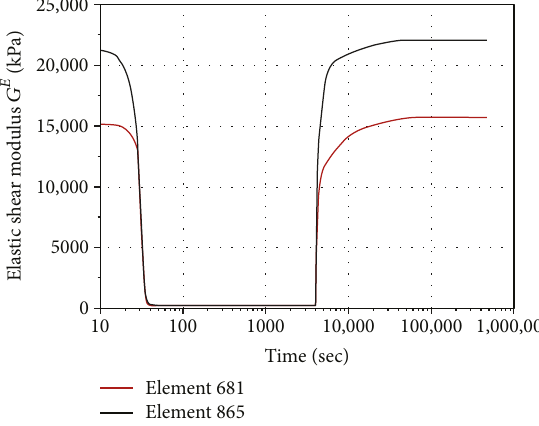
Figure 35: Recovery of elastic shear modulus for element 681 and element 865 during consolidation.